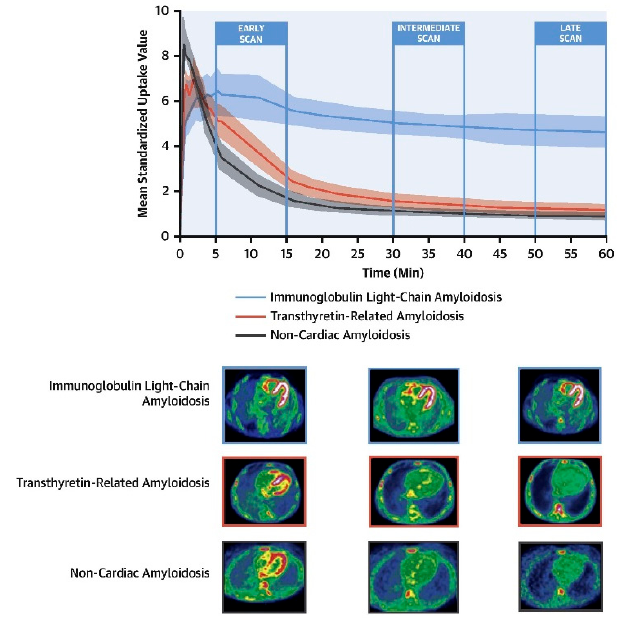
Figure 5. Cardiac 18 F-florbetaben PET scan in patients with and without CA. ( Upper panel ) The myocardial time–activity curves derived from dynamic 18 F-florbetaben PET scans in patients with non-CA (black), ATTR-CA (red), and AL-CA (blue). A shaded area for each curve represents the 95% confidence interval. ( Lower panel ) Early (5 to 15 min), intermediate (30 to 40 min), and late (50 to 60 min) 18 F-florbetaben cardiac PET scans in patients with AL-CA, ATTR-CA and non- CA.CA=cardiac amyloidosis; AL = light-chain amyloidosis; ATTR = transthyretin amyloidosis; PET= positron emission tomography ;. Reprinted from [48] , copyright (2021), with permission from Else- vier.